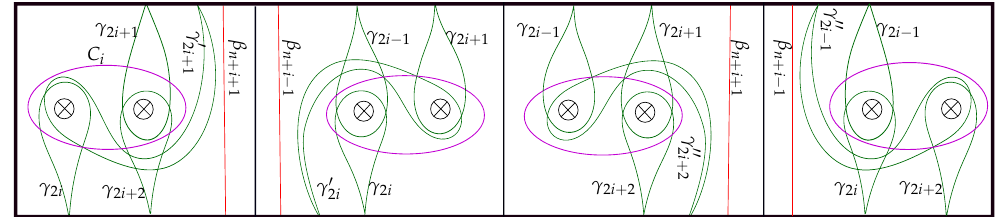
Figure 20. A scale of type I, type II, type III, and type IV from left to right.